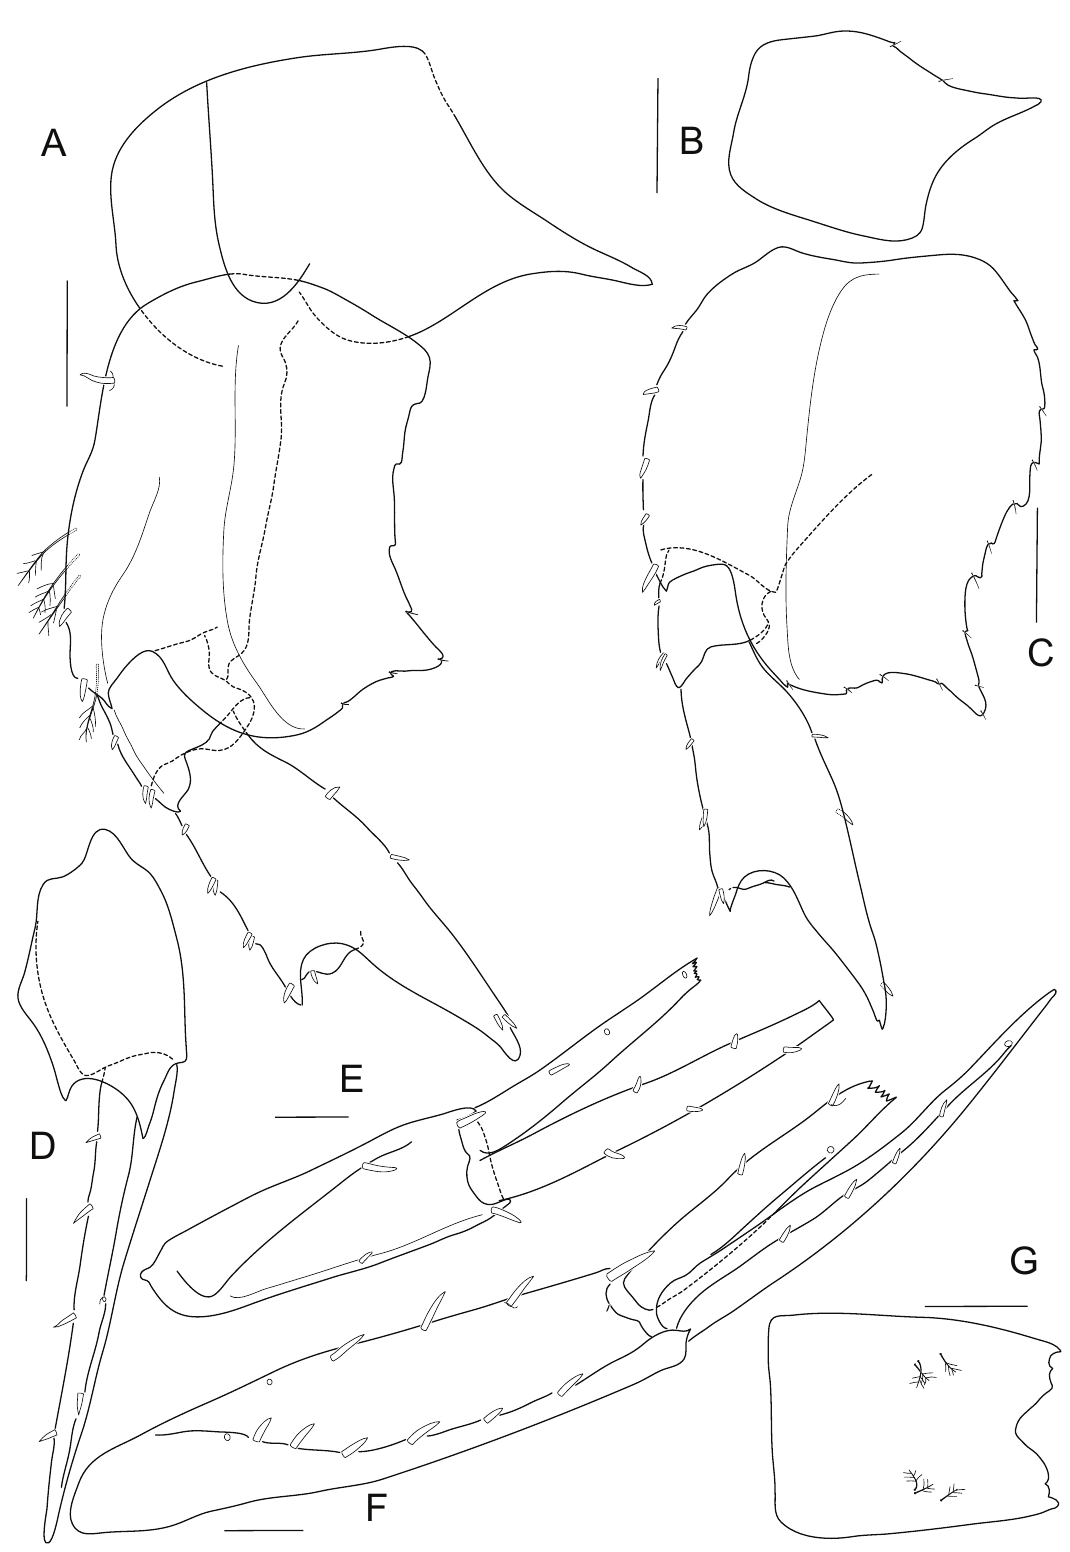
Fig. 6. Labriphimedia meikae nov. sp., holotype ♂, 6 mm, NIWA 84598. A . Pereopod 6. B . Coxa of pereopod 7. C . Basis to merus of pereopod 7. D . Uropod 3. E . Uropod 2. F . Uropod 1. G . Telson. Scale bars: a-C = 200 µm, D-G = 100